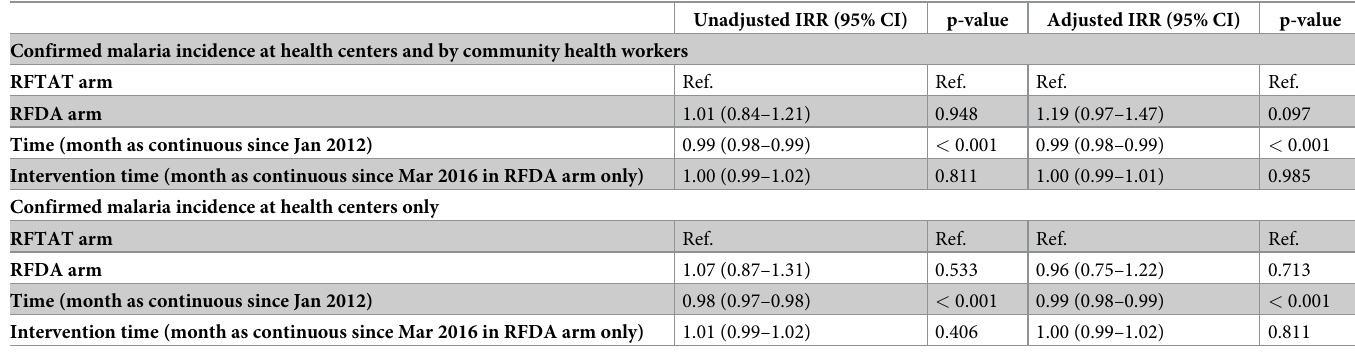
Table 3. Results from interrupted time series analyses of confirmed malaria